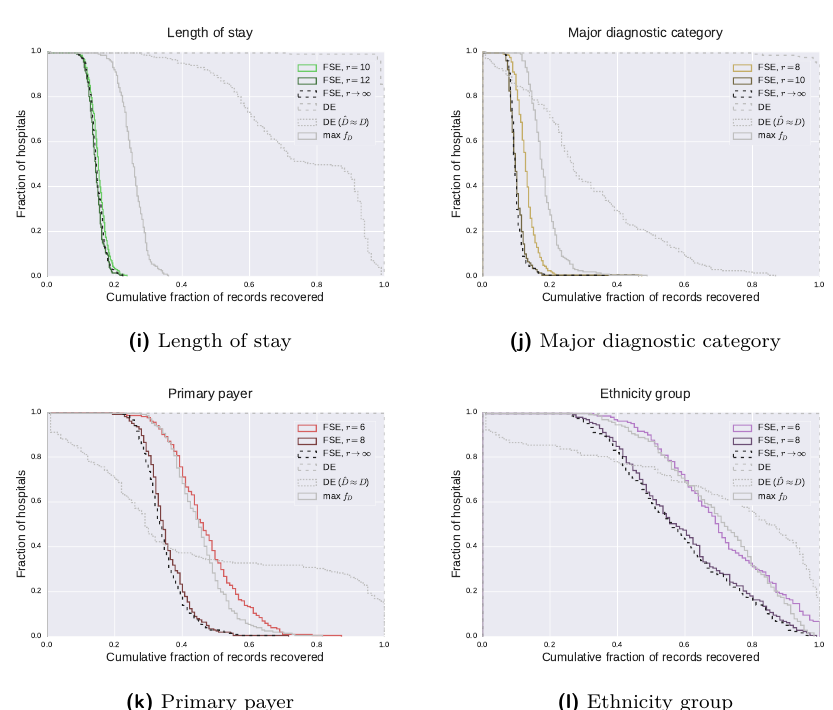
Figure 7: Our experimental results by attribute: complementary cumulative distributions (continued from two previous